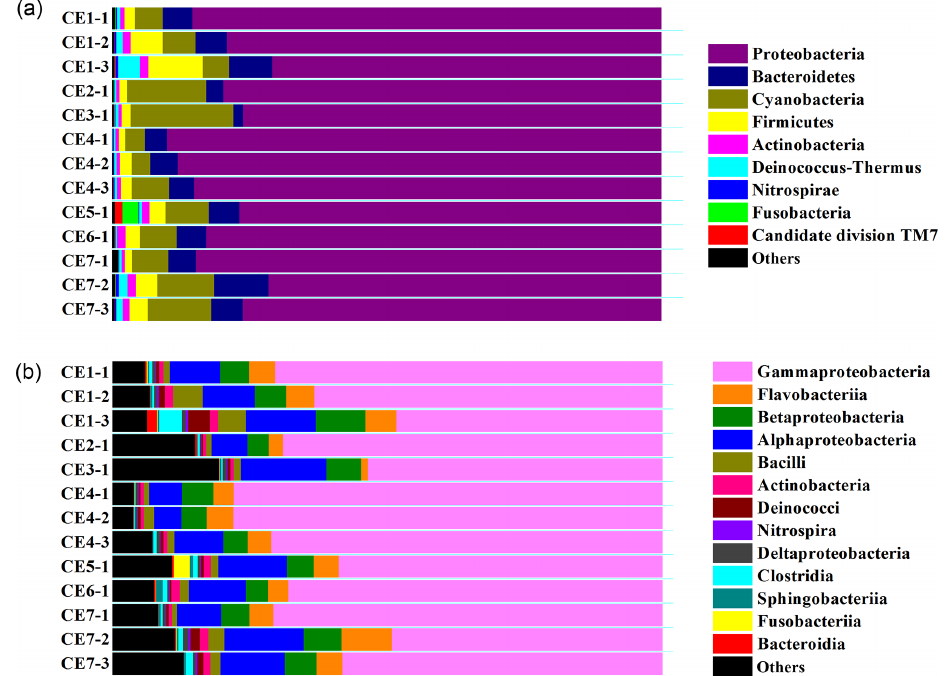
Figure 1. Bacterial community variation for cloud episodes at the phylum (a) and class (b) level. CE refers to the cloud episodes. Bar graphs for each sample represent the percentage of taxa assigned to each phylum with 80% bootstrap confidence. Taxonomic summary of the most abundant taxa (more than 1%) across all cloud samples are indicated in the